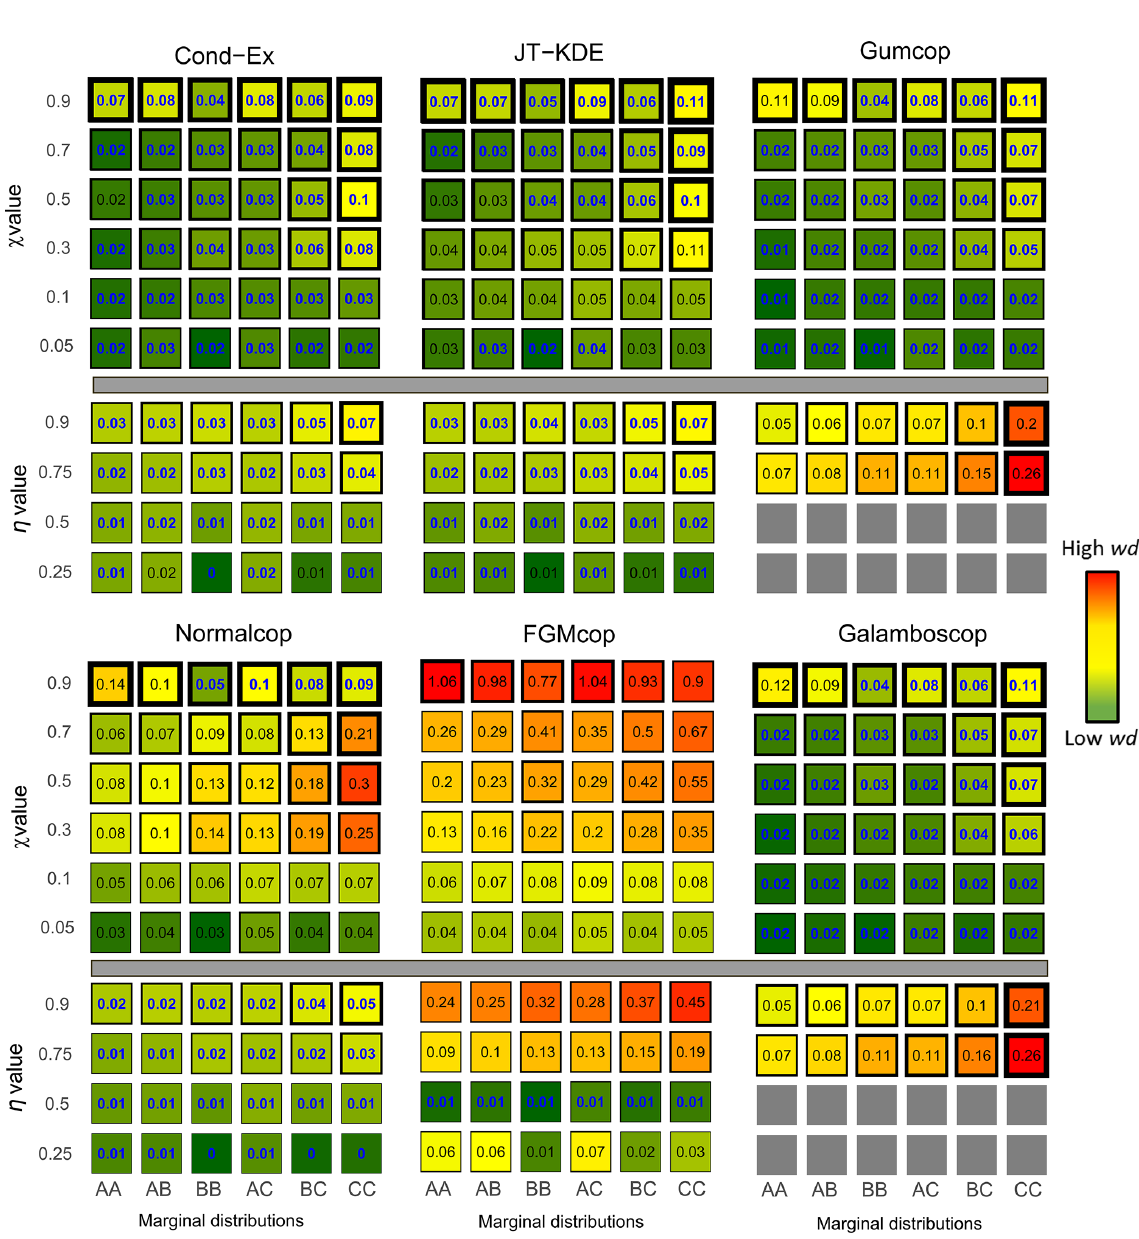
Figure 7. Weighted normalized Euclidean distance ( wd ) to the reference curve for all 60 different synthetic datasets. Fitting capacities of each model are represented. Values in cells and colours represent the median wd from low (dark green) to high (red). Bold blue values highlight cases where models are representative of the data. Thickness of borders represent the 95% uncertainty around the median value on a logarithmic